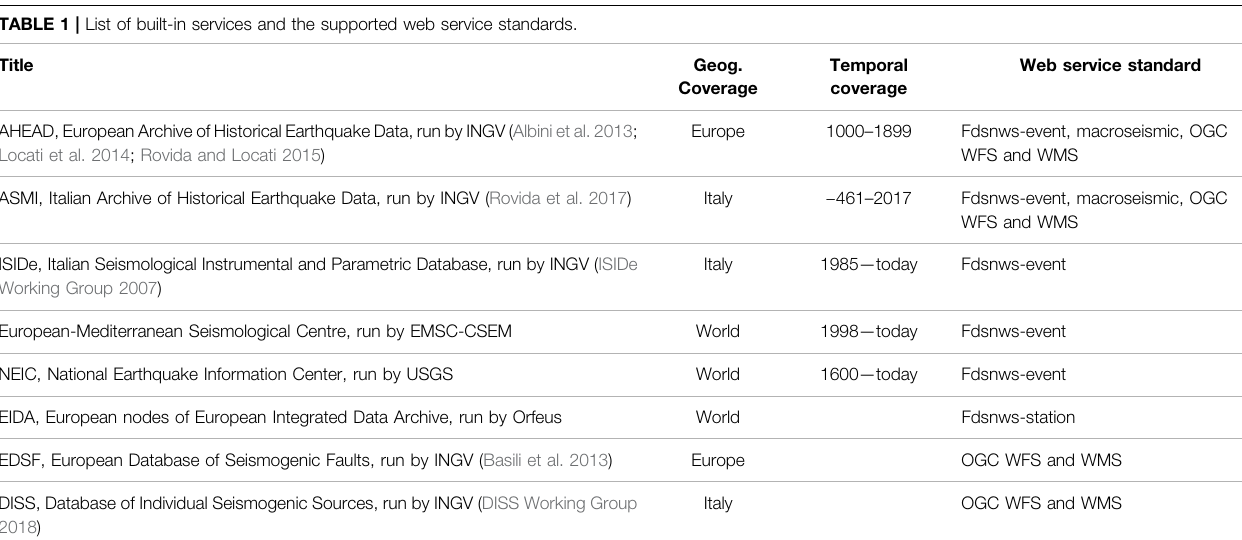
TABLE 1 | List of built-in services and the supported web service standards.